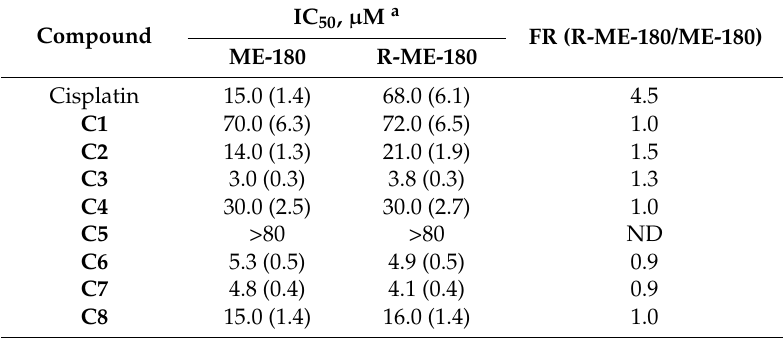
Table 3. Half-maximal inhibitory concentrations (IC 50 ) of cisplatin and gold (III) compounds in cervical cancer cell line ME-180 and its cisplatin-resistant R-ME-180 clone and fold resistance